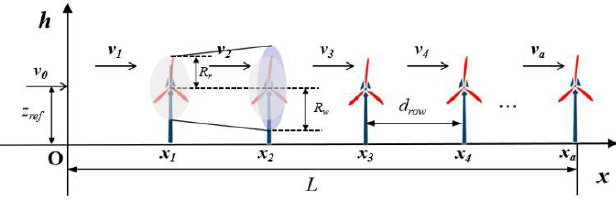
Figure 3. Illustration of WTs’ wake on a flat area.